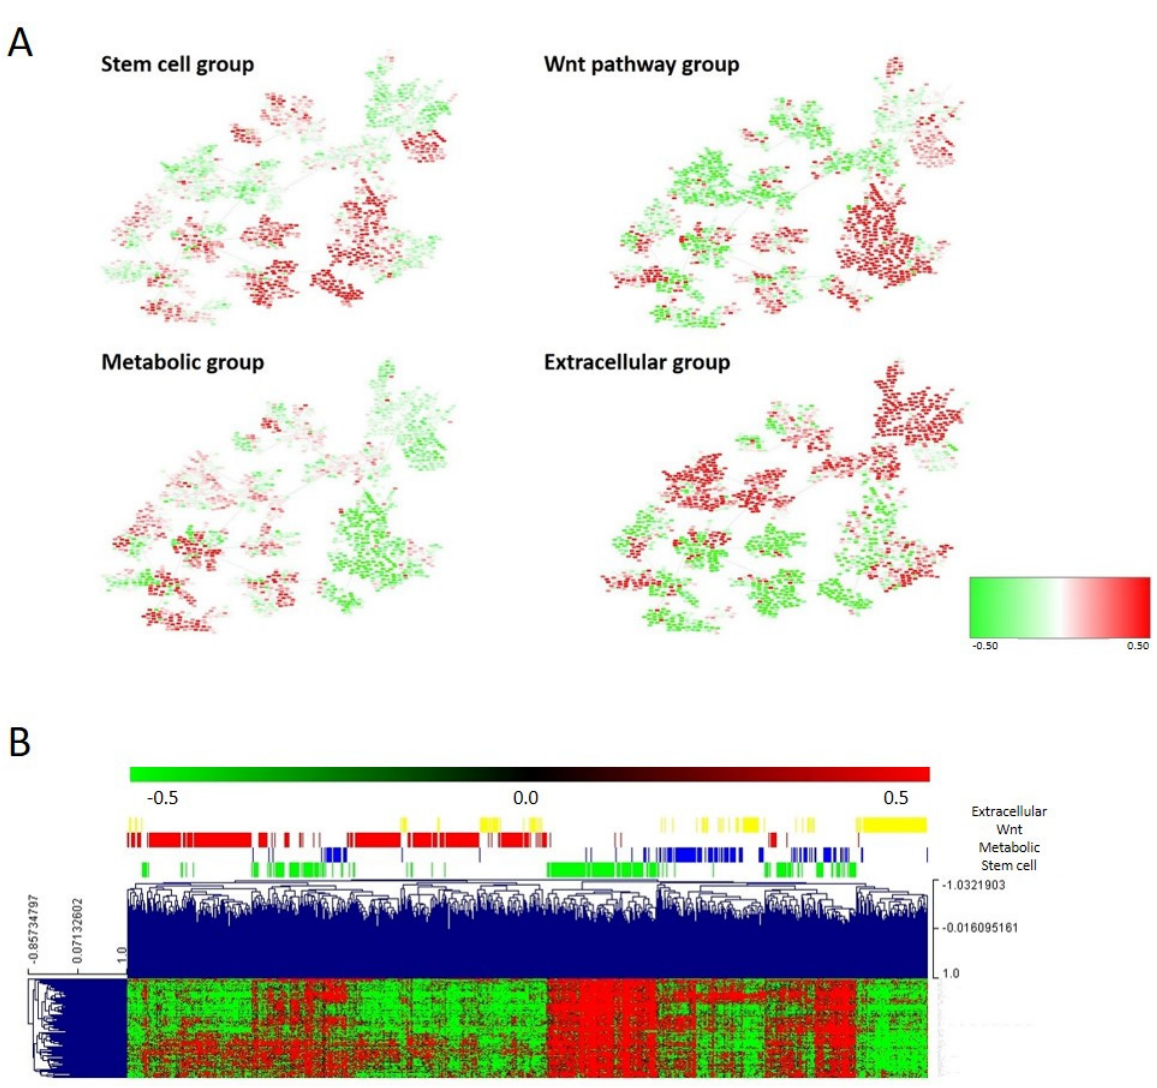
Figure 6. ( A ) Heatmap of the mean gene expression of the four molecular groups in the PGM. Red = overexpressed. Green = underexpressed. ( B ) One hundred differential genes between the four molecular groups.